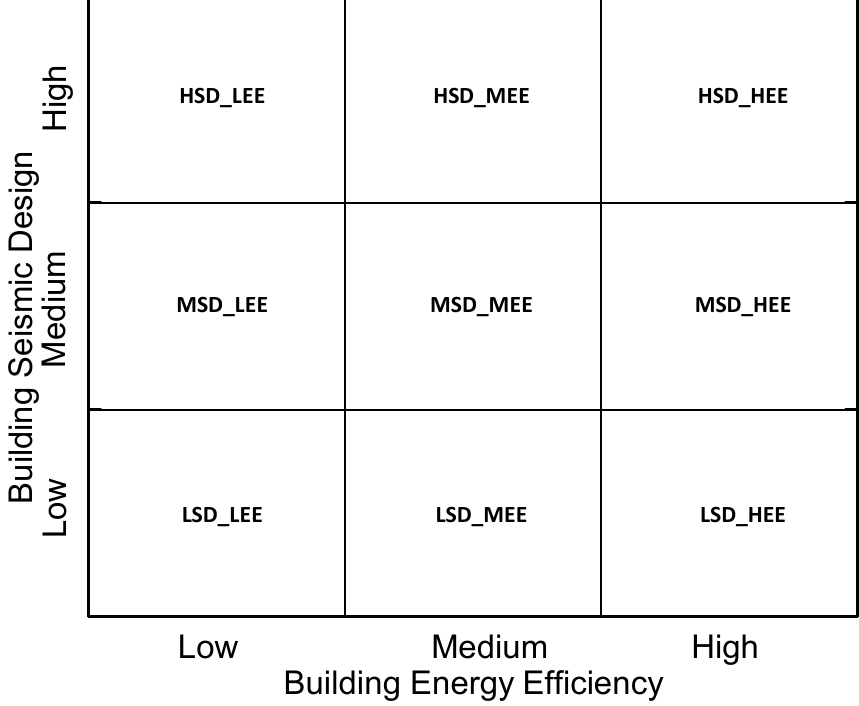
High Table 5. Definition of masonry building typologies proposed for retrofitting scenarios. Nomenclature